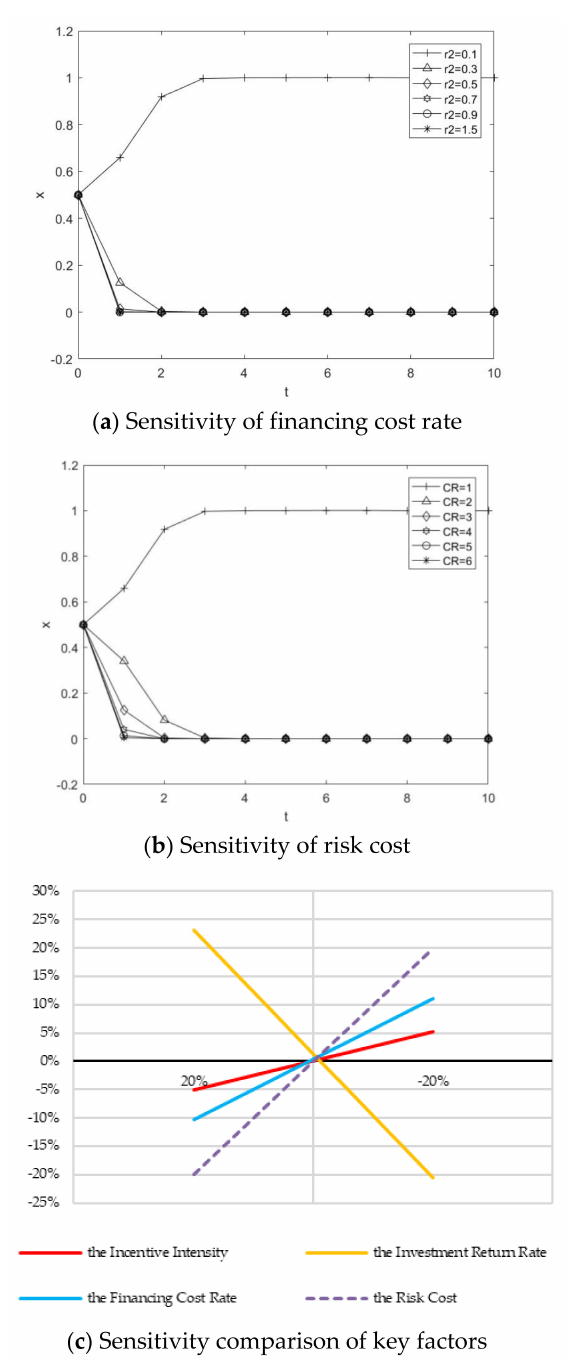
Figure 3. Sensitivity of key factors of participation